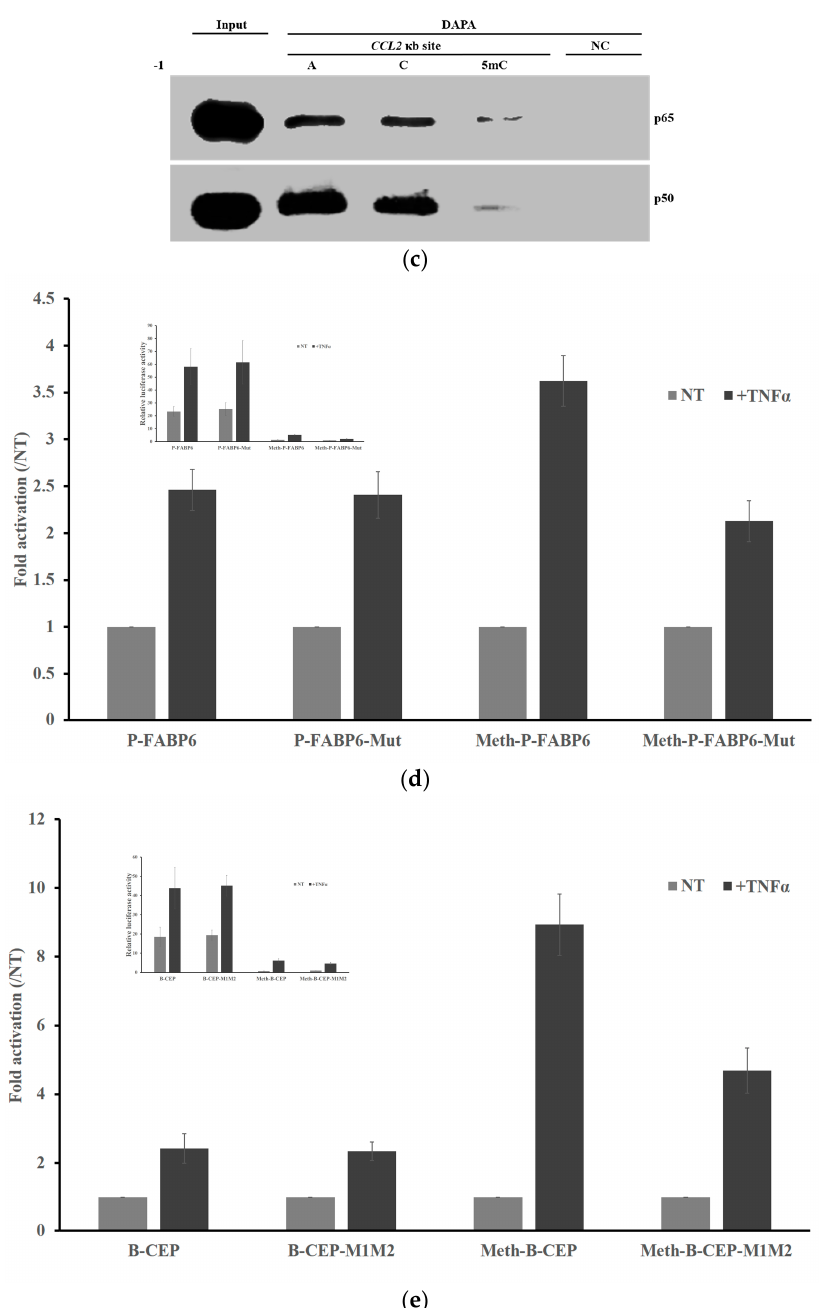
Figure 3. Methylation of the -1C nucleoside inhibited the binding and function of NF- κ B. ( a ) Sequences of the oligonucleotides with tandem FABP6 or CCL2 κ B sites used in DAPA. The κ B site sequences were underlined, the nucleotides at -1 position were in bold; ( b , c ) DAPA using FABP6 ( b ) or CCL2 ( c ) oligonucleotides shown above and lysates of HEK 293T cells treated with TNF α (10 ng/mL) for 30 min. Oligonucleotides-bound NF- κ B was detected by Western blot analysis using antibodies against p65 or p50, respectively. NC, negative control oligonucleotide. Input, 2% of the whole cell lysate used in DAPA; ( d , e ) Reporter assays of TNF α (10 ng/mL, 18 h) treated HEK 293T cells transfected with plasmids shown in the figures. Fold activations are the luciferase activities of TNF α treated group normalized to their untreated controls. The inserts shown are the relative luciferase activities of all eight reporters in each experiment. ( b , c ) are the results of one of three experiments. Data shown in ( d , e ) are means ± S.D. of the results from at least three independent experiments.